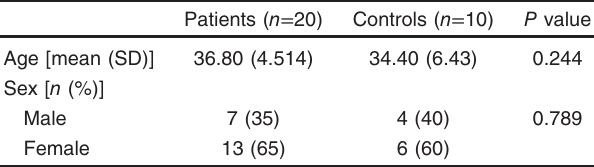
Table 1 Demographics of patients with multiple sclerosis and controls